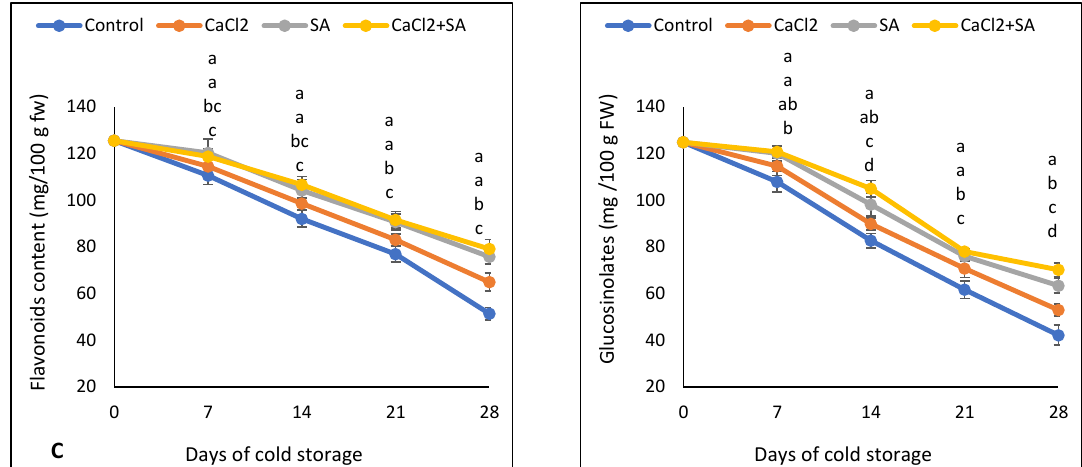
Figure 4. Effect of SA and CaCl 2 and their combination on ( A ) total phenolic, ( B ) vitamin C, ( C ) flavonoids, and ( D ) glucosinolates of broccoli florets stored at 5 ◦ C for 28 days. Values are means ± SE from three replicates ( n = 3). Same letter means no significant differences between the values ( p < 0.05) according to Duncan test.